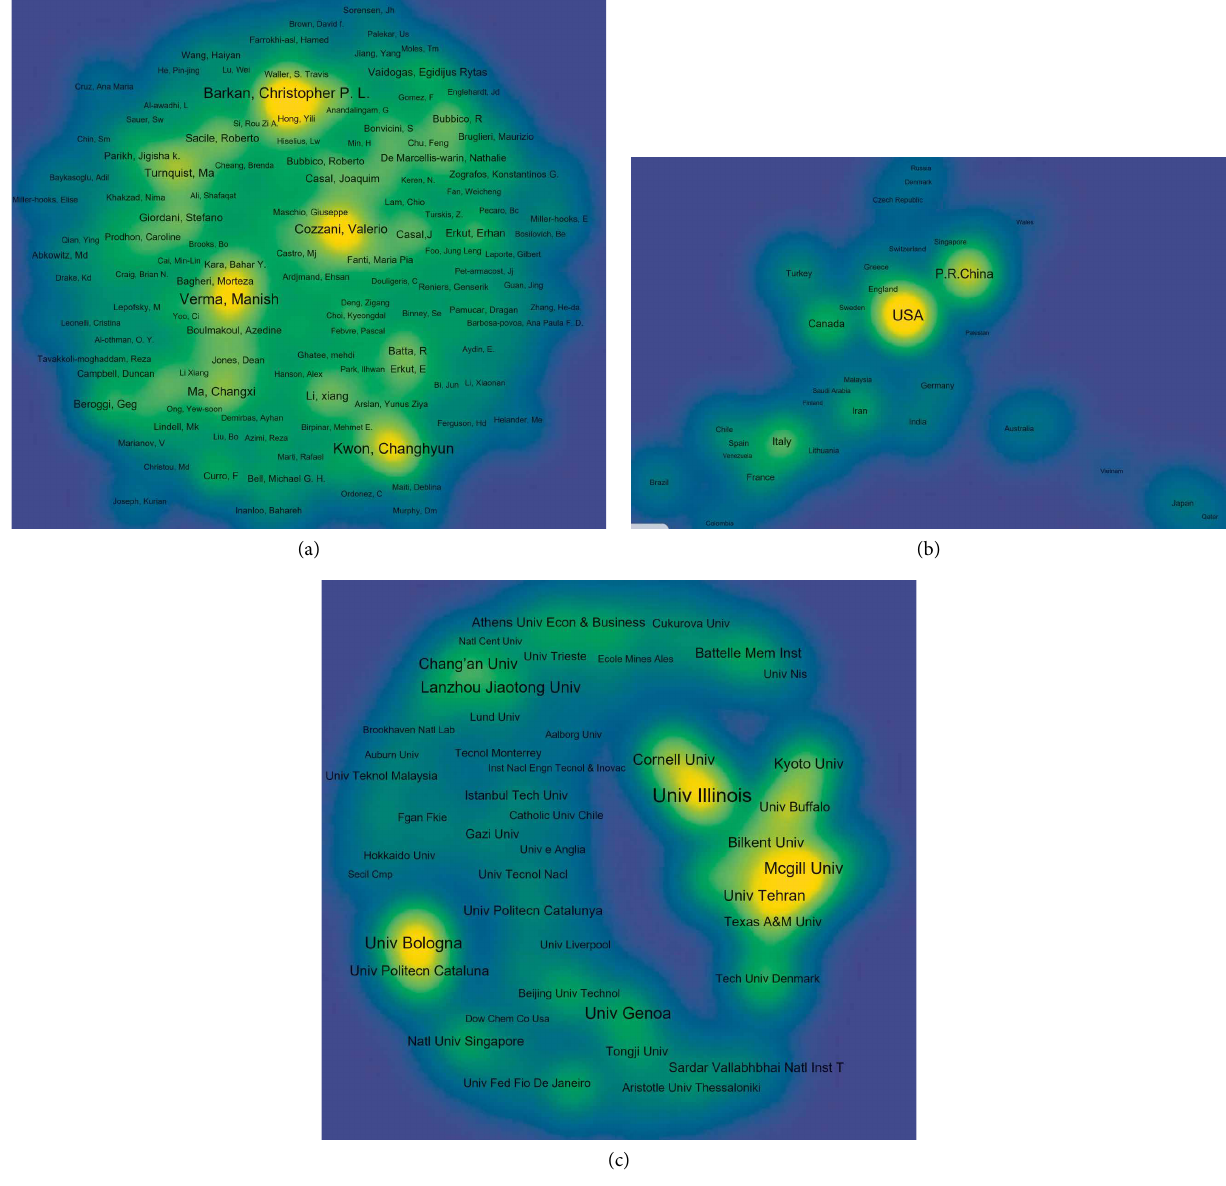
Figure 2: Visualization of hazardous materials transportation in current studies: (a) the citation network among productive authors; (b) the countries among productive authors; (c) the collaboration network among research